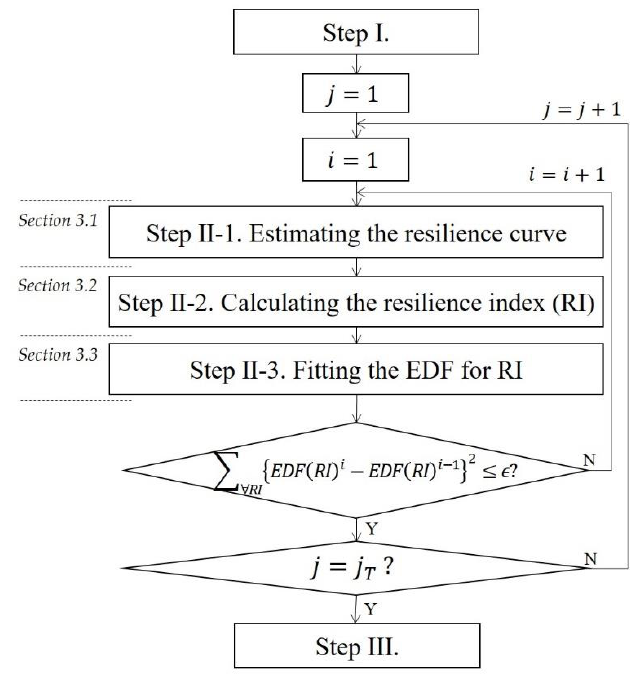
Figure 2. Probabilistic estimation process of resilience based on MCS.